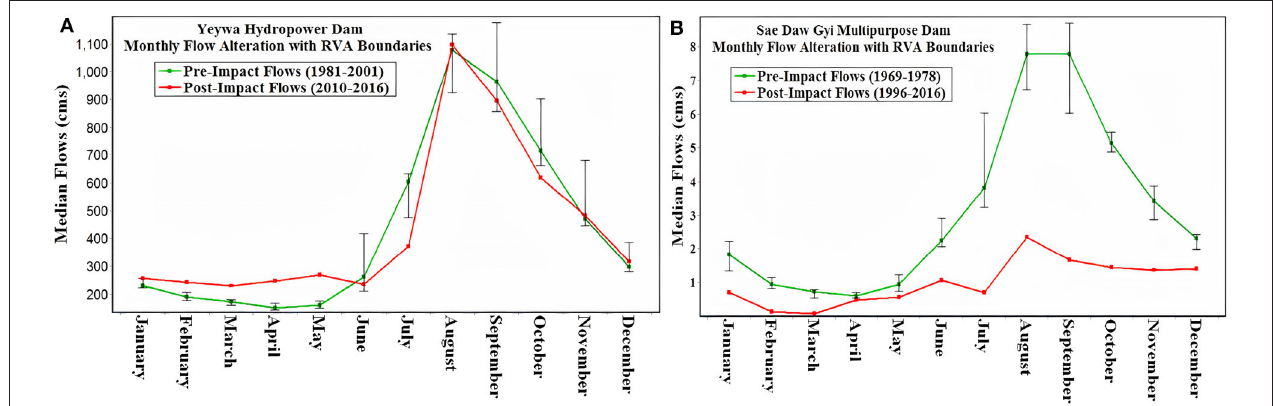
FIGURE 2 | Monthly flow alteration of pre- and post-impact periods (A) on the Myitnge River downstream of Yeywa dam and, (B) on the Chaungmagyi River downstream of Sae Daw Gyi dam.